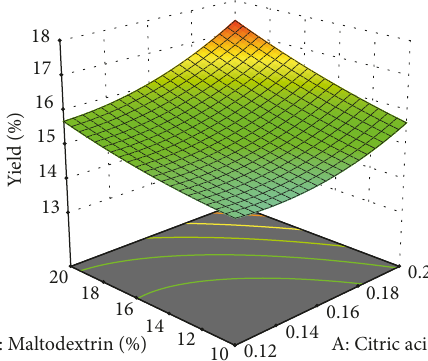
Figure 1: Yield of cheese analogue from sweet corn extract was affected by concentration of citric acid and